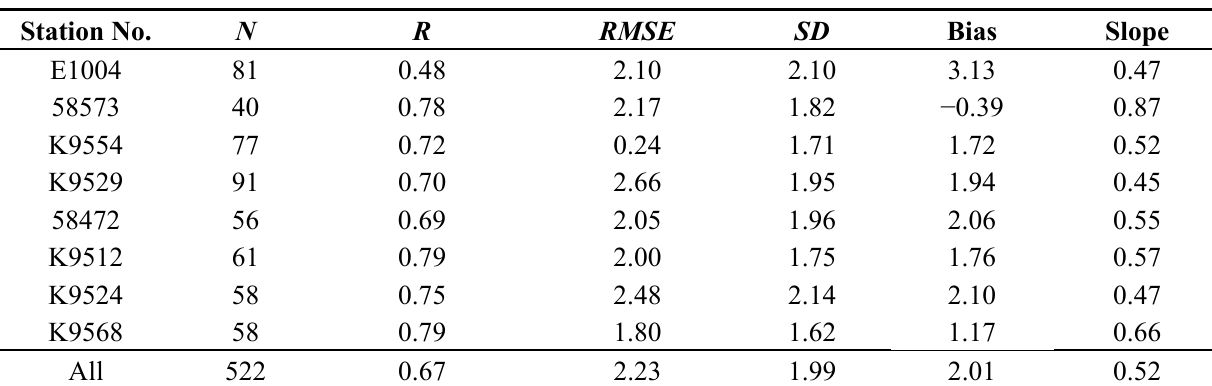
Table 3. Linear regression results for wind speed between in situ data vs. SAR-wind. N is number of comparing samples, R is the correlation coefficient, SD is the standard deviation (m/s); RMSE is root mean square error (m/s); Bias is the offset of the linear regression; and the Slope is the slope of the linear